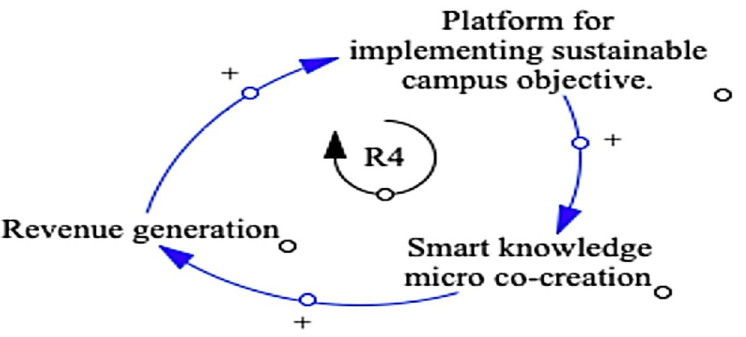
Figure 5. Reinforcing loop R4.